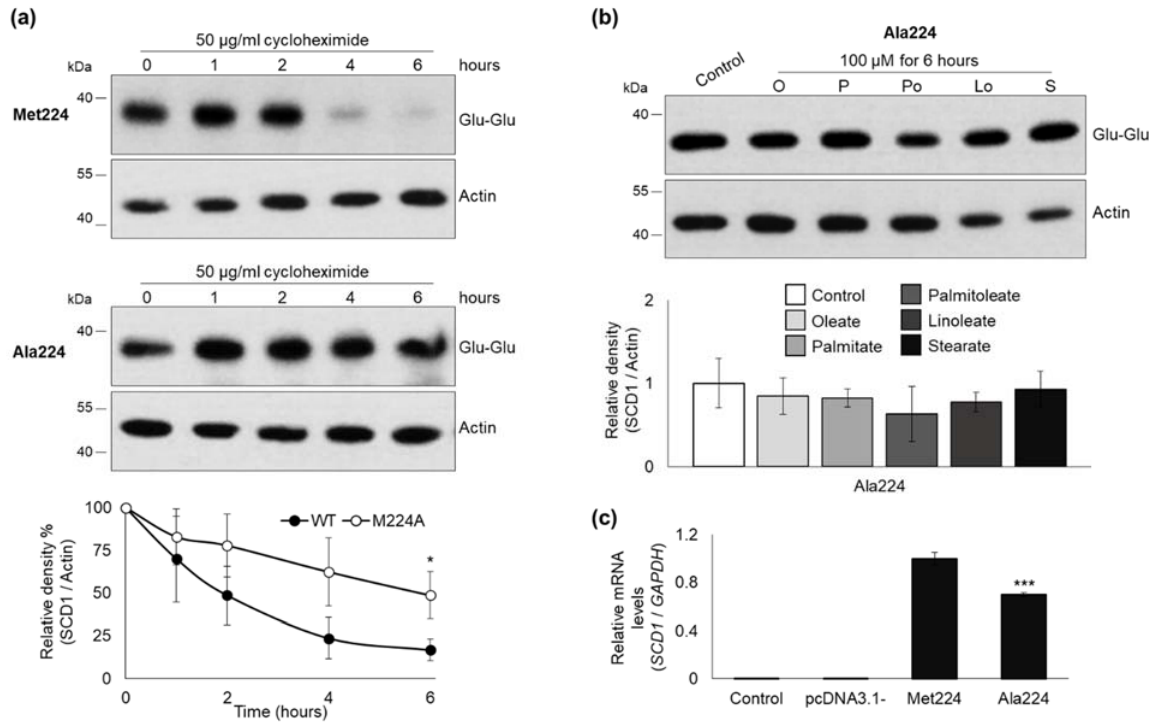
Figure 7. Expression, stability, and fatty acid sensitivity of Ala224 artificial SCD1 variant. ( a ) HEK293T cells were transiently transfected with Glu-Glu tagged Met224 and Ala224 constructs. 24 h after transfection cells were treated with cycloheximide (50 mg/mL) for 0, 1, 2, 4, and 6 h. Western blot analysis of cell lysates (2 µ g protein per lane) was carried out using anti-Glu-Glu tag and anti-Actin antibodies. Representative result of four independent experiments is shown. The band intensities were determined by densitometry and the SCD1-Glu-Glu/Actin ratios were plotted. ( b ) 24 h after transient transfection, cells were treated with BSA-conjugated oleate, palmitate, palmitoleate, linoleate, and stearate to a final concentration of 100 µ M for 6 h. Immunoblot analysis of cell lysates (2 µ g protein per lane) was carried out using anti-Glu-Glu tag and anti-Actin antibodies. Representative result of three independent experiments is shown. The band intensities were quantitated by densitometry and SCD1-Glu-Glu/Actin ratios are shown as bar graphs. ( c ) qPCR was elaborated using GAPDH and SCD1 -Glu-Glu tag sequence specific primers as indicated in Section 4. The diagram presented depicts the results of three independent measurements. Statistical analysis was performed with the Tukey–Kramer Multiple Comparisons Test. Data are shown as mean values ± S.D. * p < 0.05; *** p < 0.001.